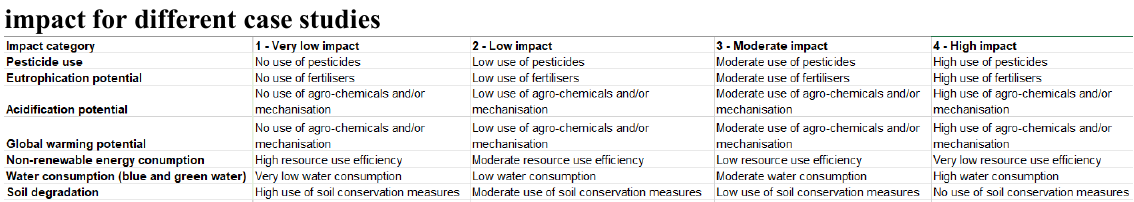
Table B1. Criteria used in addition to life-cycle assessment metrics used to score